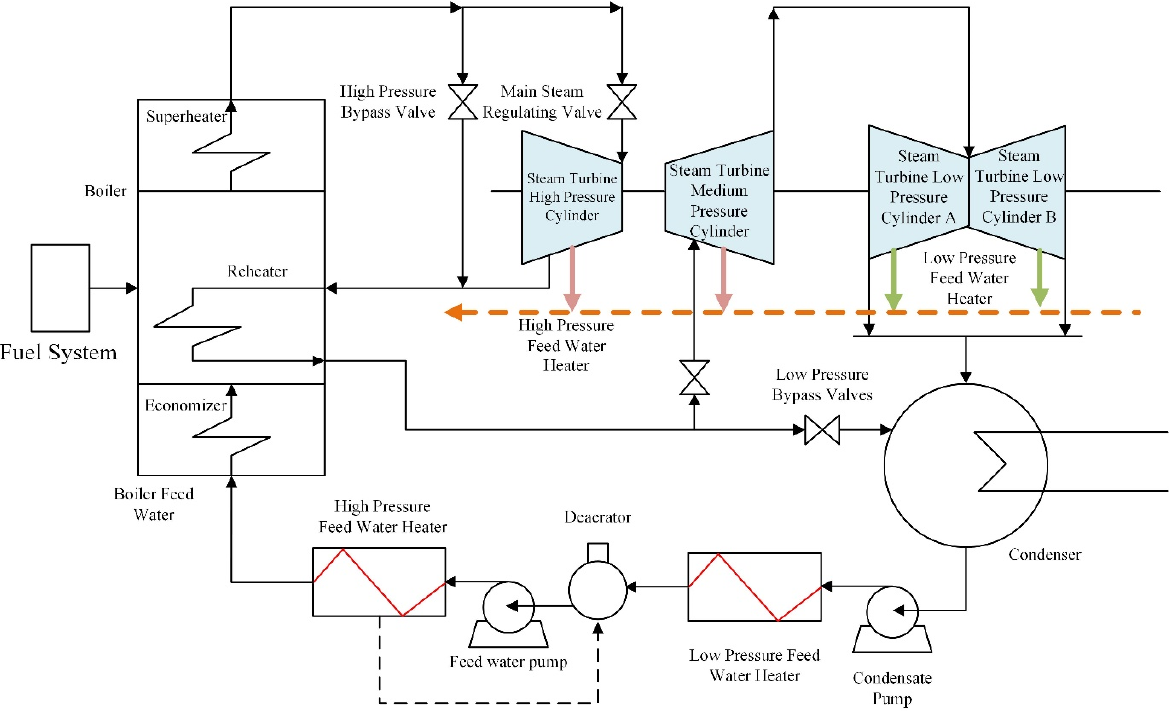
Figure 14. Schematic diagram of thermal power unit.